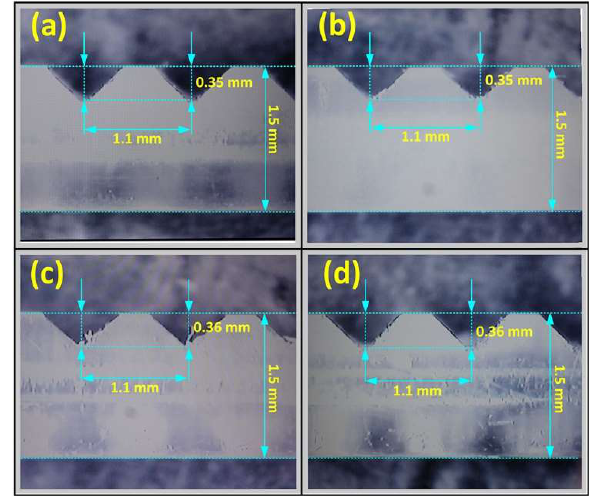
Figure 3. Teeth of the FOCS.